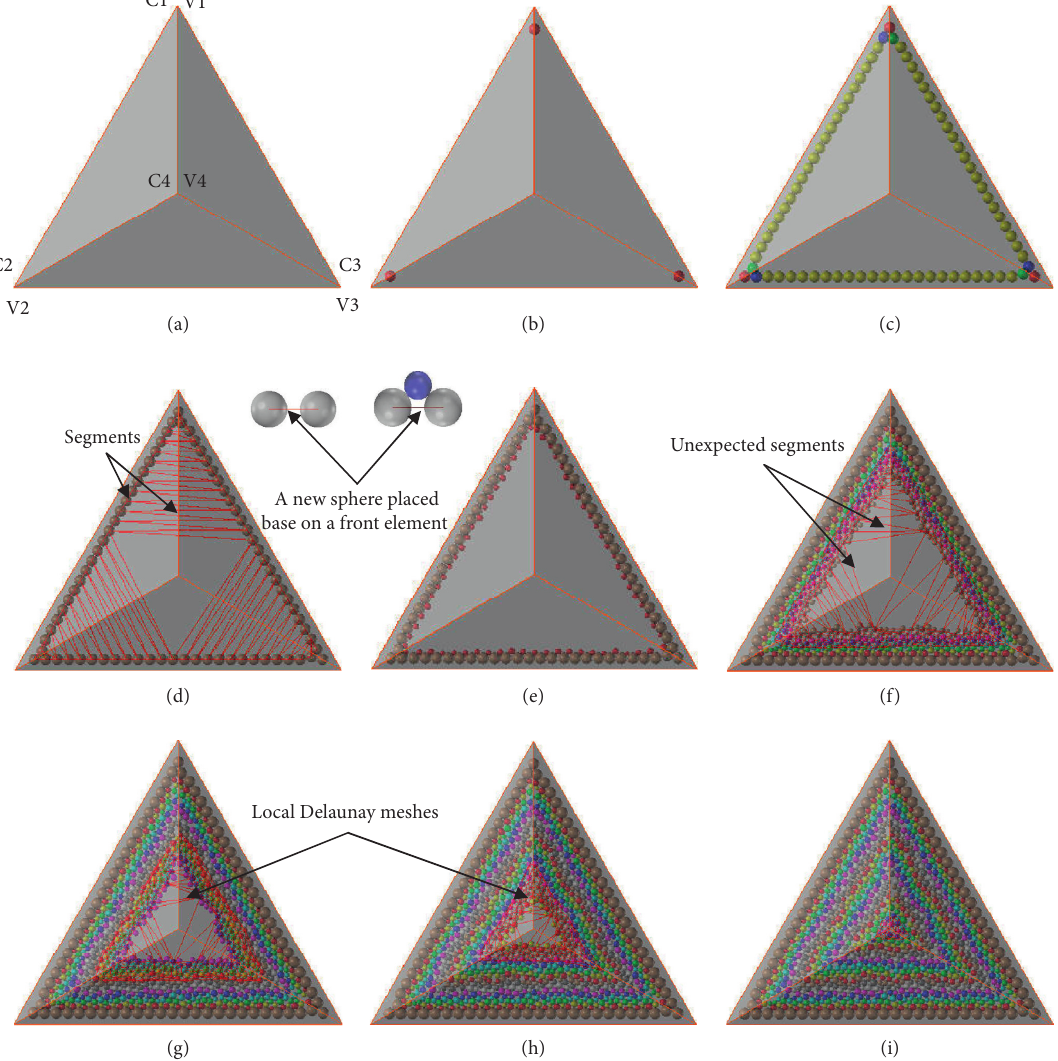
Figure 2: A flow chart of the algorithm for clump generation for a polyhedral particle:(a) the tetrahedral particle; (b) placement of spheres at corners; (c) placement of spheres along edges; (d), (e), (f), (g), (h), and (i) placement of spheres on a